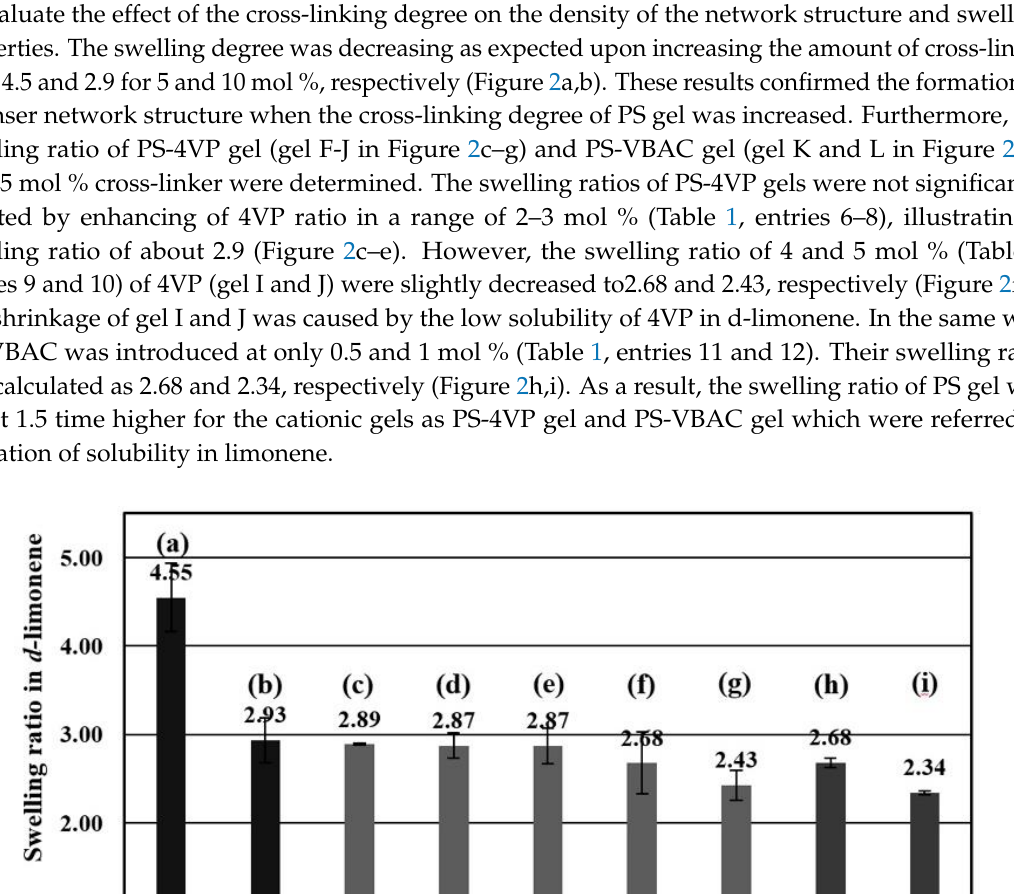
Figure 3. Elastic modulus (G’) from rheological measurement at frequency 0.1– 10 Hz of 5 mol % cross- linker PS gel; Gel A ( a ) and Gel B ( b ), 10 mol % cross-linker PS gel; Gel C ( c ) and Gel D ( d ), PS-4VP